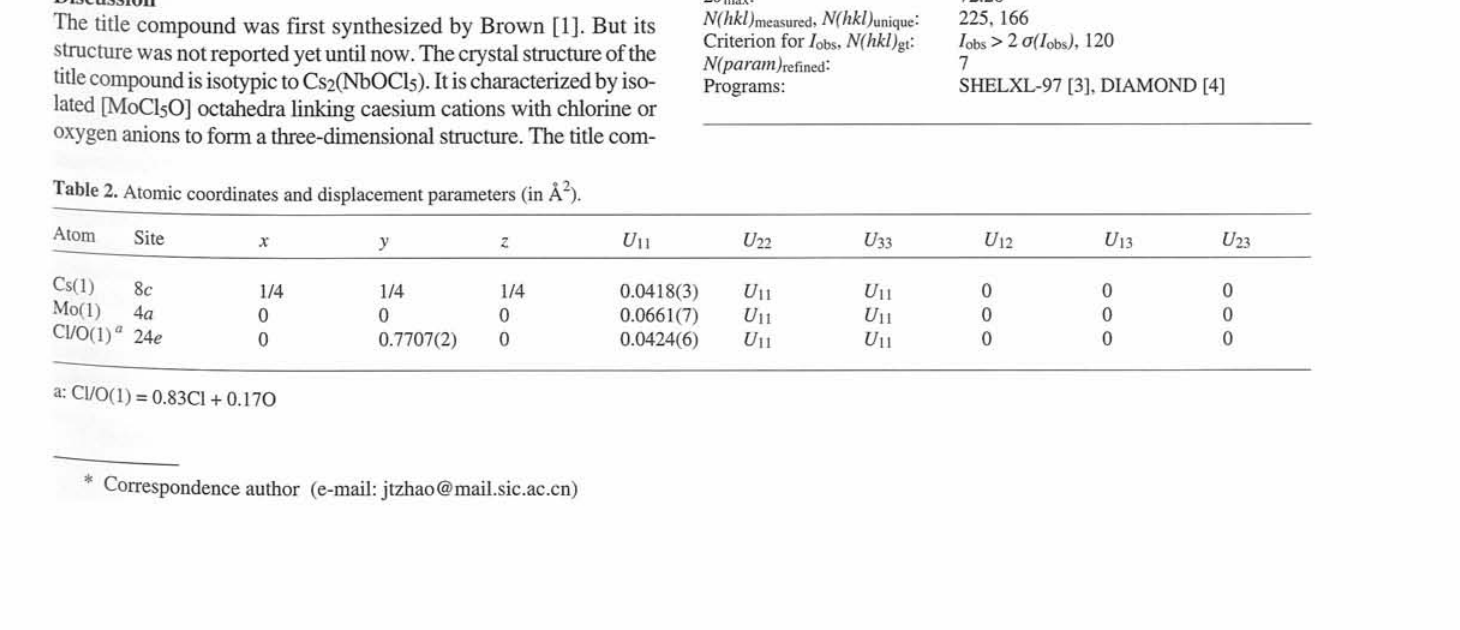
Table 2. Atomic coordinates and displacement parameters (in Â 2